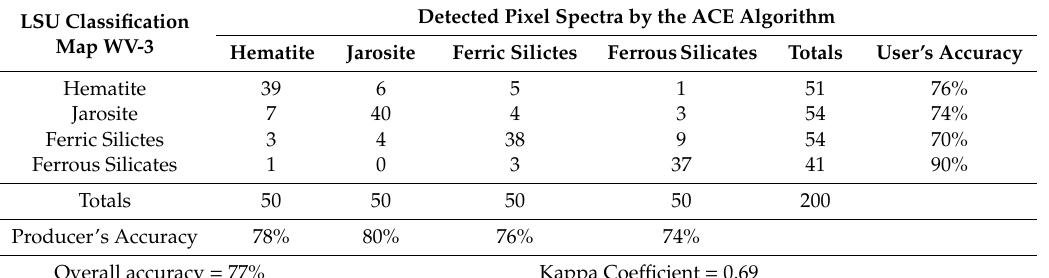
Table 8. Confusion matrix for the LSU classification image-maps derived from WV-3 versus the ACE fraction images derived from VINR + SWIR bands of